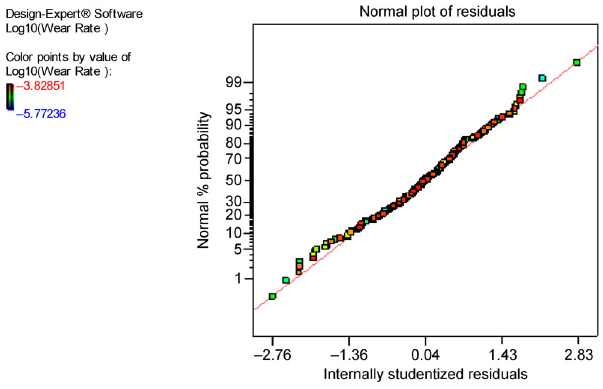
Fig. 4 Normal plot of residuals for W R .